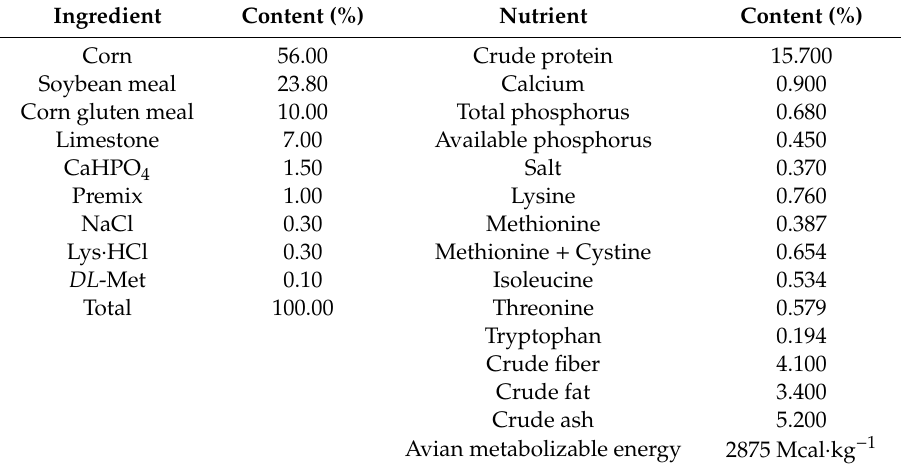
Table 2. The feed composition of black Muscovy